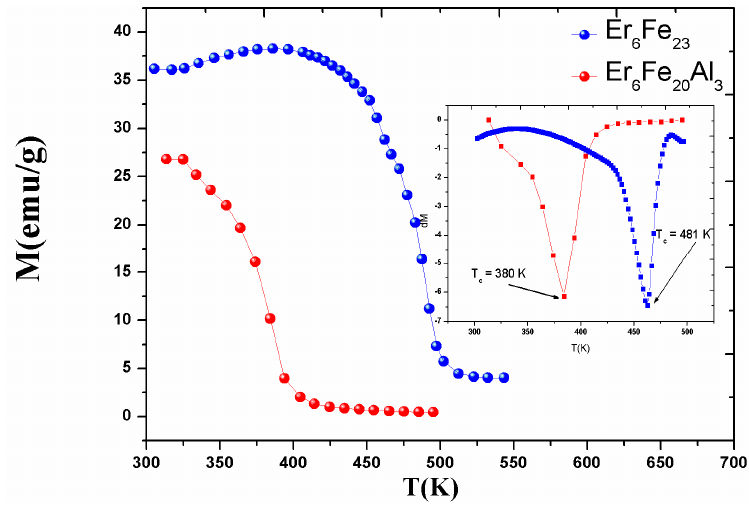
Figure 3. Temperature dependence of magnetization of Er 6 Fe 23-x Al x with x = 0 and 3 under a low applied magnetic field μ 0 H = 0.1 T.